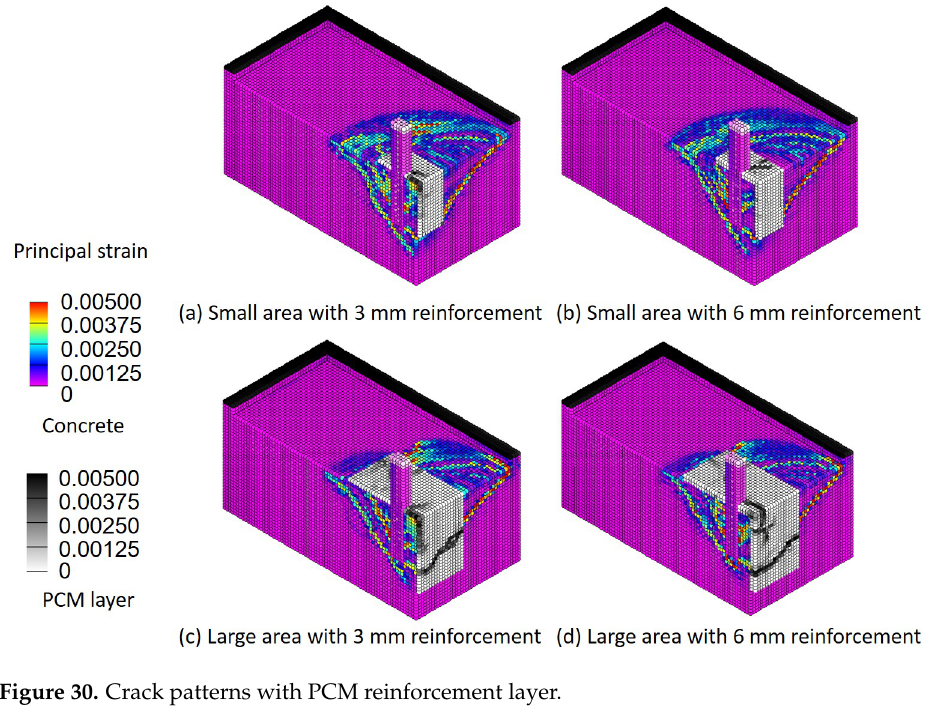
Figure 30. Crack patterns with PCM reinforcement layer.